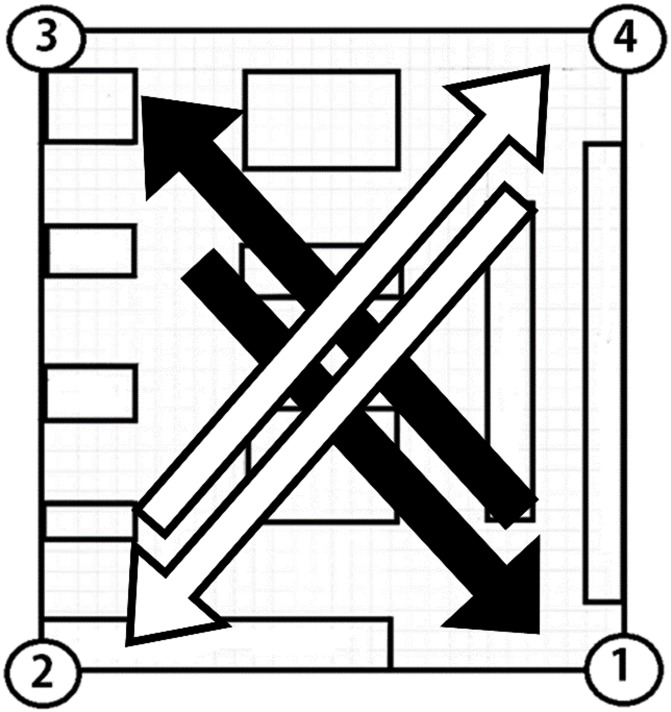
Layout of indoor mobility course.Schematic top view of the indoor mobility course used during experimentation. The numbered corners represent start and/or stop points for each trial. Each start point had a stop point at the diagonal corner of the room (direction of travel represented by arrows)